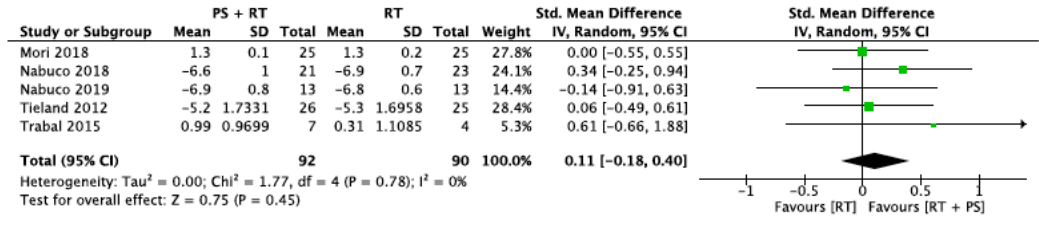
Figure 7. Impact of RT + PS on gait speed.